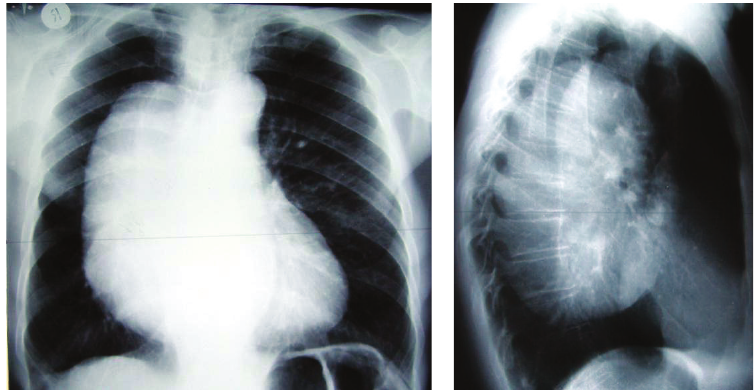
Figure 1: Preoperative chest X-ray showing a large intrathoracic tumor.